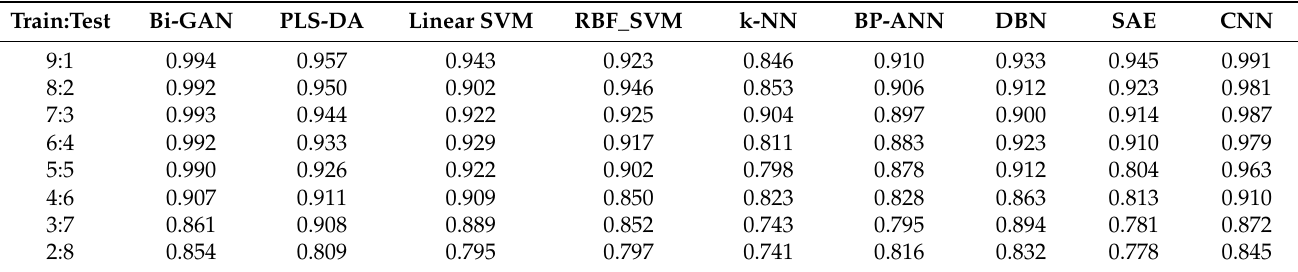
Table 3. Accuracy of various multi-class classification